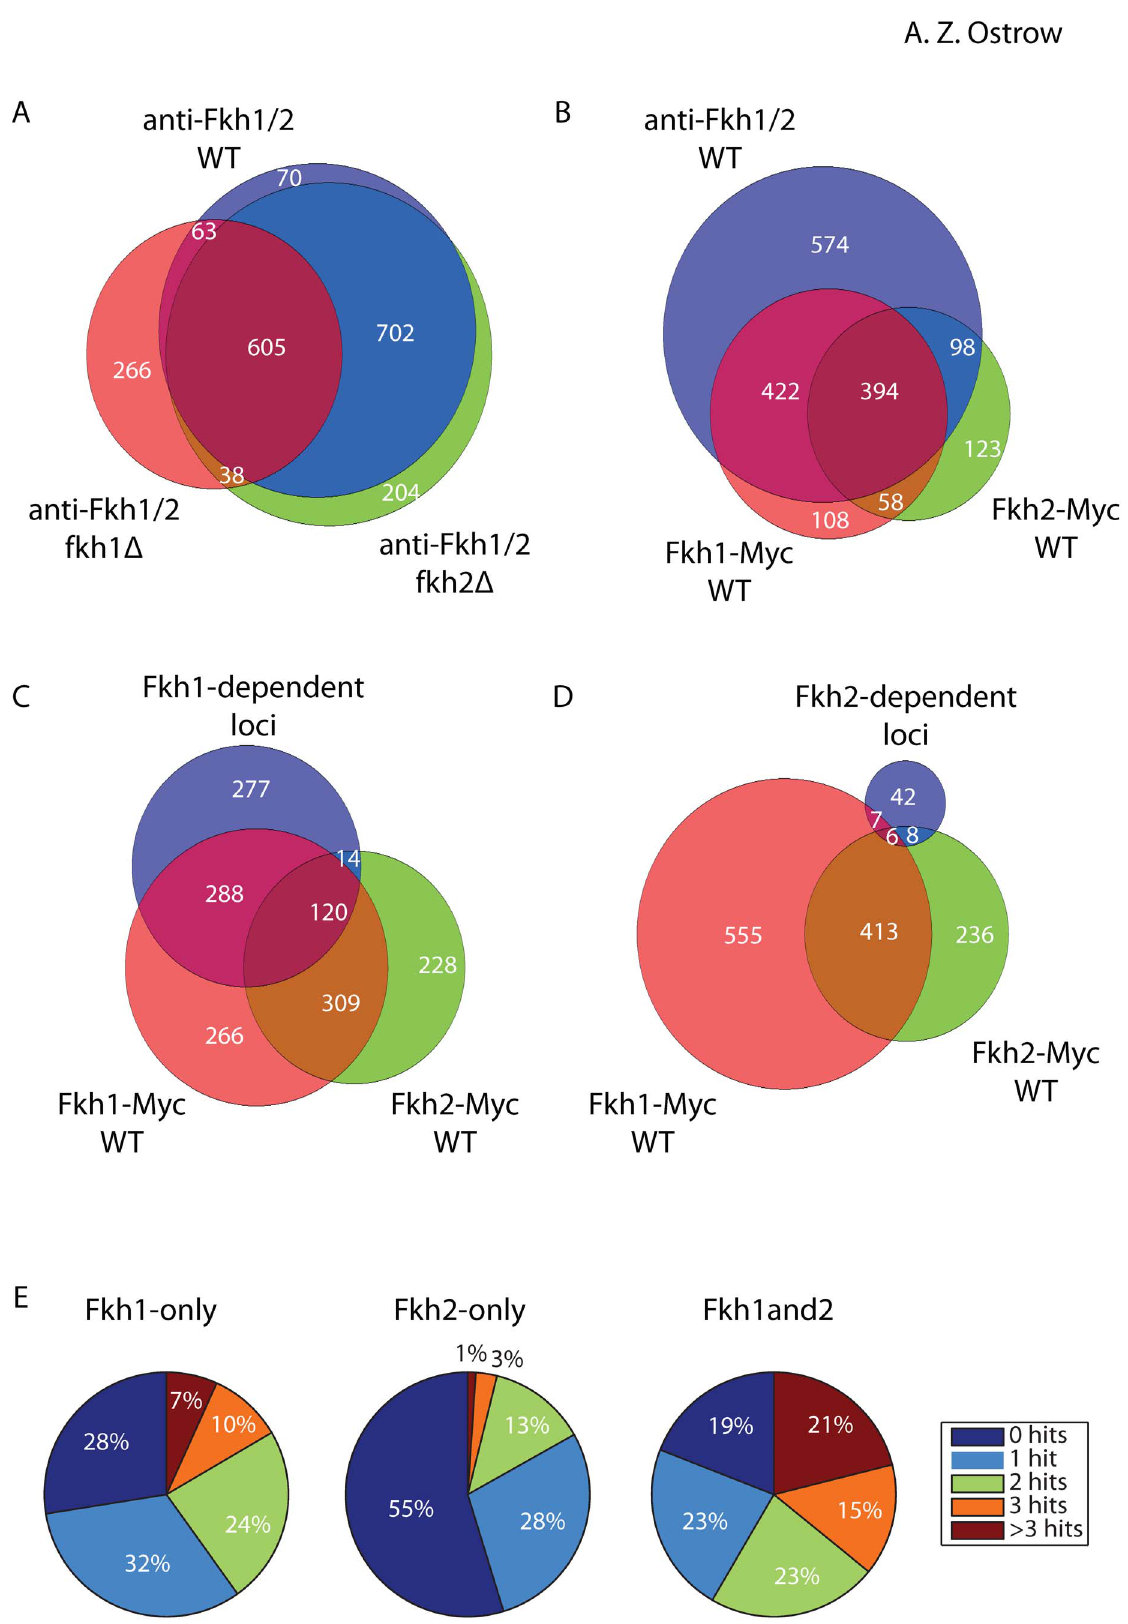
Figure 2. Correlation of Fkh1 and Fkh2 binding sites identified in different experiments. A–D ) Venn diagrams show overlap between binding regions identified and/or categorized in different experiments. The area of the circle representing each group and the degree of intersection